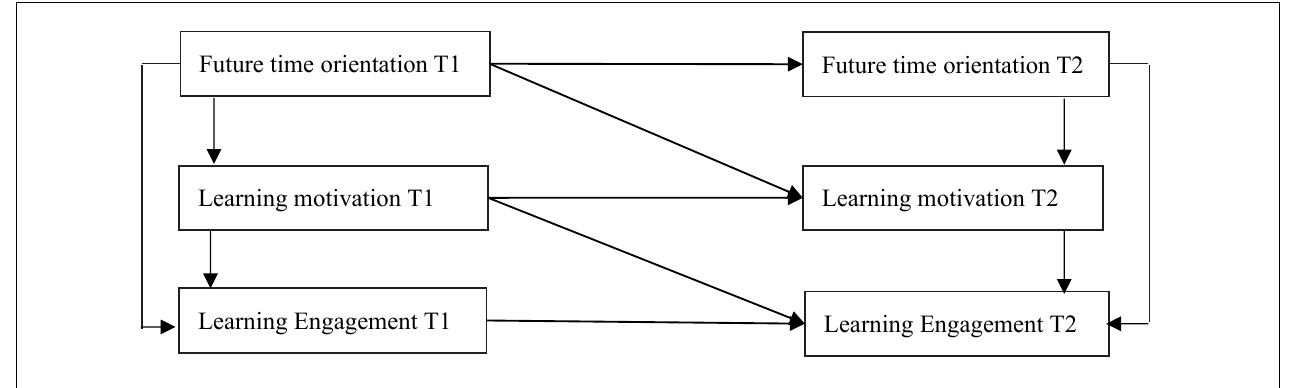
FIGURE 1 | Research